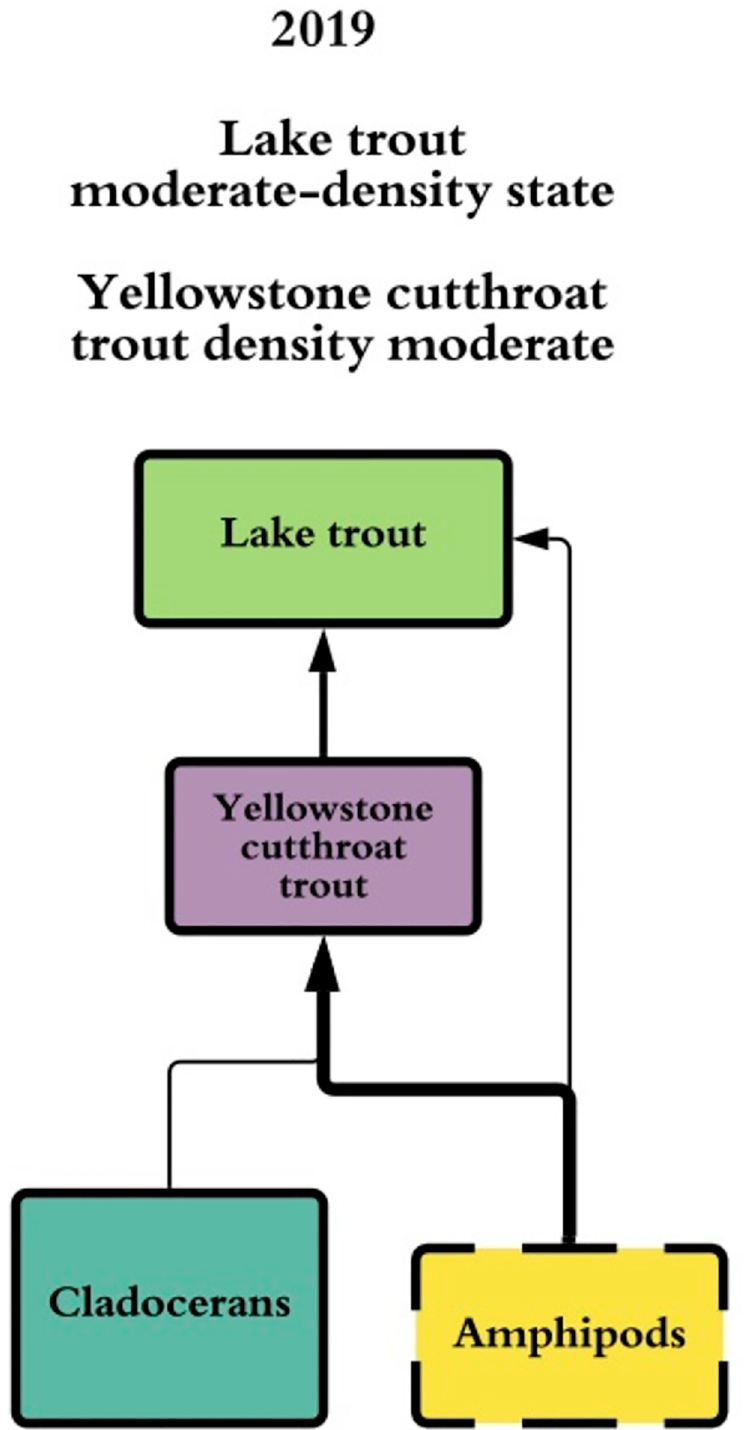
Fig 3. Contemporary diet. Simplified representation of Yellowstone cutthroat trout and > 300 mm lake trout diets during the moderate-density state (~300,000 > 300 mm lake trout; estimate of lake trout density from Syslo et al. [55]). Size and thickness of solid-lined boxes represents relative densities of organisms, thickness of lines represent relative contributions of organisms to predator diet, size and thickness of dashed boxes represents inferred density of organisms based on previous